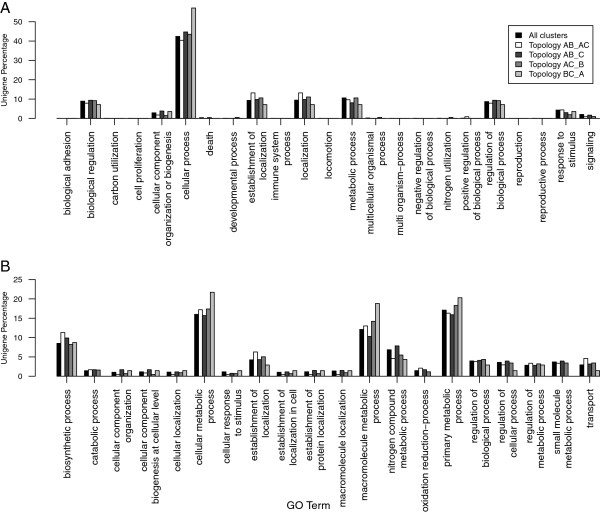
Gene Ontology analysis of Nicotiana gene clusters.  Plot showing the percentage of Nicotiana  gene clusters annotated with level 2 (A) and level 3 (B) Biological Process Gene Ontology terms for all gene clusters and each of the main phylogenetic tree topologies (AB_AC, AB_C, AC_B and BC_A). Bars are coloured according to topology group (see inset key for identification).